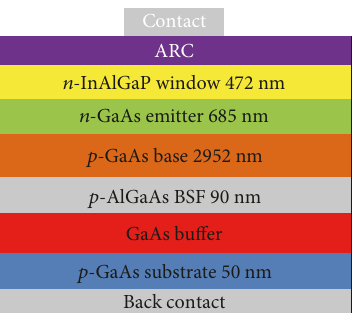
Figure 12: Schematic diagram of the optimized single solar cell structure.